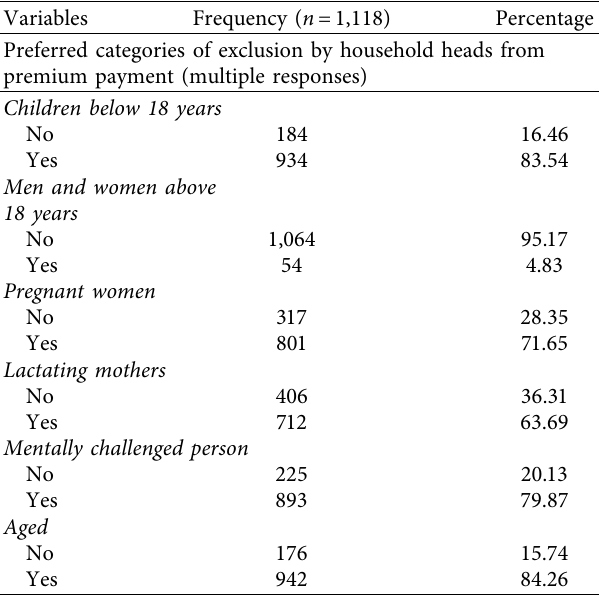
Table 4: Preferred choices for benefit